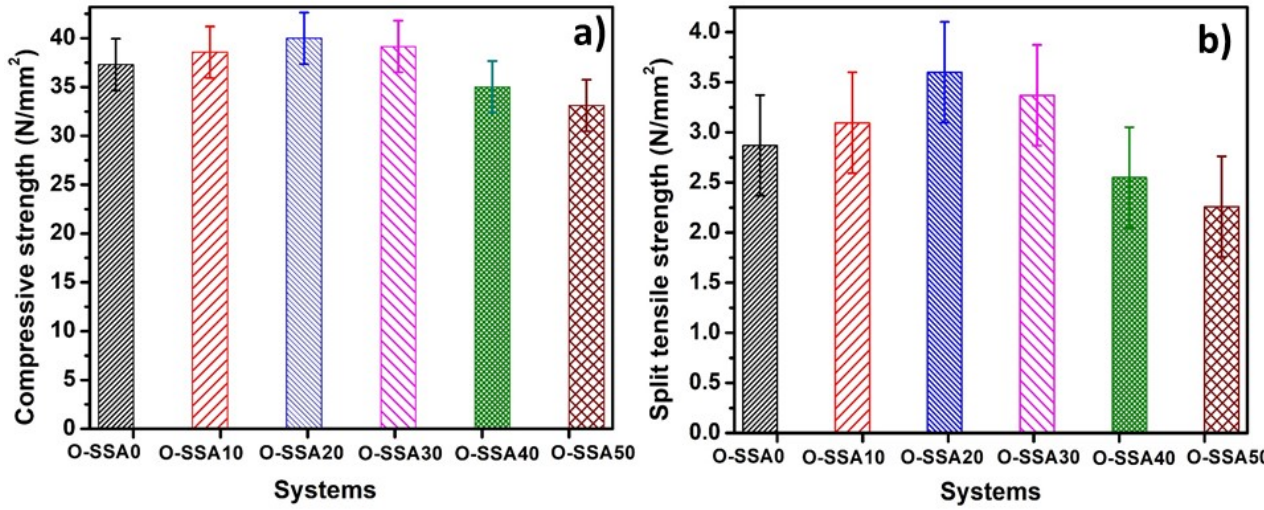
Figure 13. Mechanical properties of the concrete with a different replacement level of SSA . Compressive strength test ( a ); and split tensile strength test ( b ).